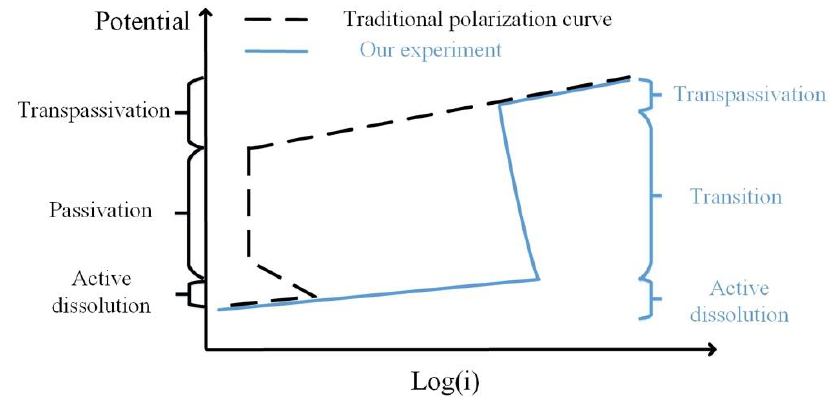
Figure 11. Schematic diagram of the traditional polarization curve and our experiment result.